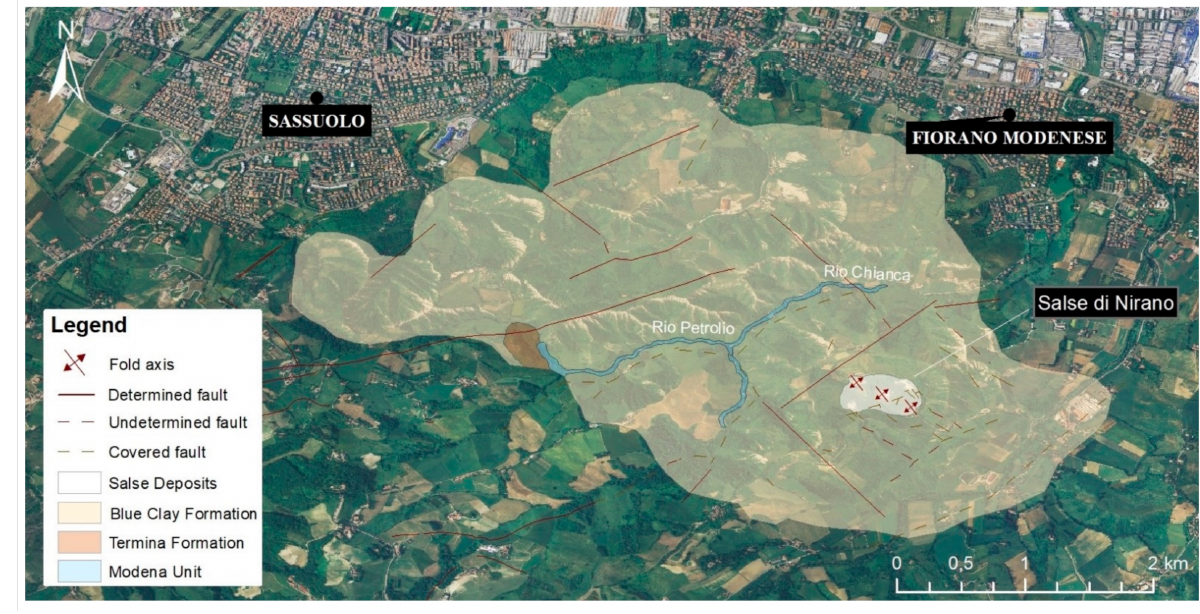
Figure 3. Litho-structural sketch of the study